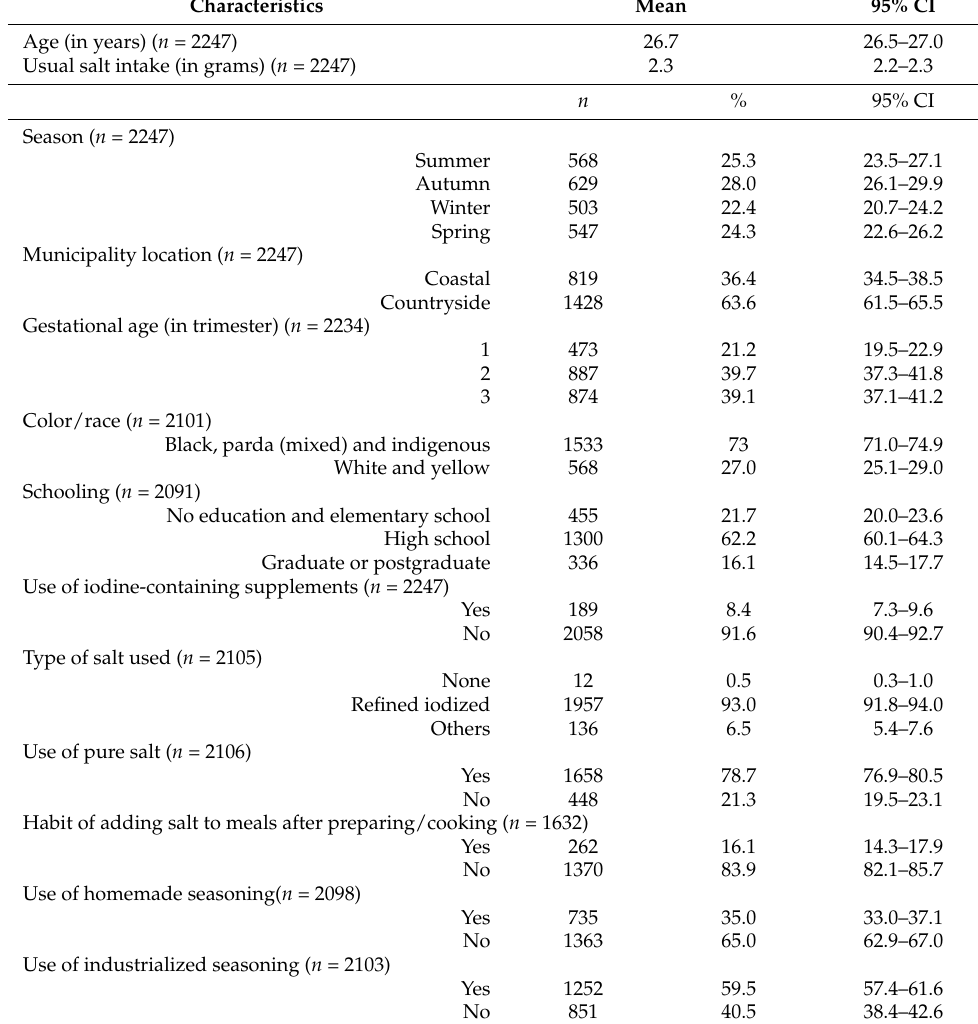
Table 2. Characteristics of pregnant women from Multicenter Study of Iodine Deficiency, Brazil, 2023.